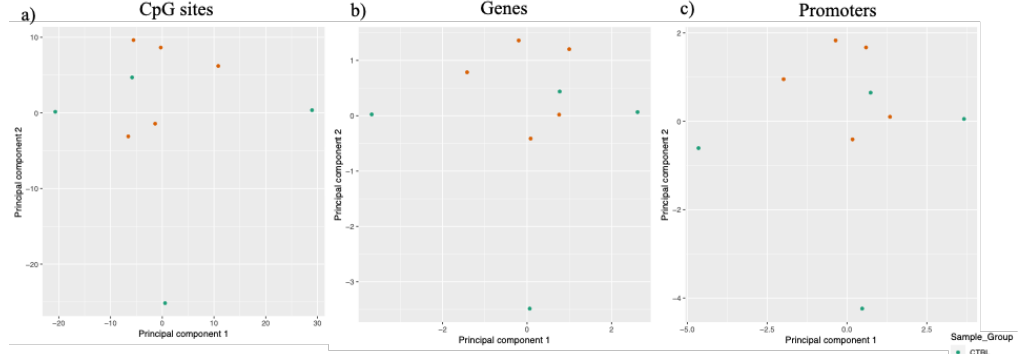
Figure 1. Principal Component Analysis for the Fabry Disease Group and CTRL Group. PCA plots showing the cluster of Fabry and CTRL groups in orange and in green, respectively. The plots are shown considering the DNA methylation levels at CpG sites ( a ), genes ( b ) and promoters ( c ). We then performed hierarchical clustering based on the methylation levels at sites/ regions with the highest variance across all samples. In doing so, we could select CpGs, promoters and genes that may be more discriminative between the FD group and the CTRL group. We found that especially at the CpG site and at promoter levels, a partial cluster of samples belonging to the FD group (in orange) and the CTRL group (in green) was present (Figure 2), with the exception of a nonaffected patient. These findings may indicate that, even though the global methylome was not sufficient to discriminate FD and CTRL groups, a deeper analysis allowed us to identify methylation signatures at given promoters and at specific CpG sites.